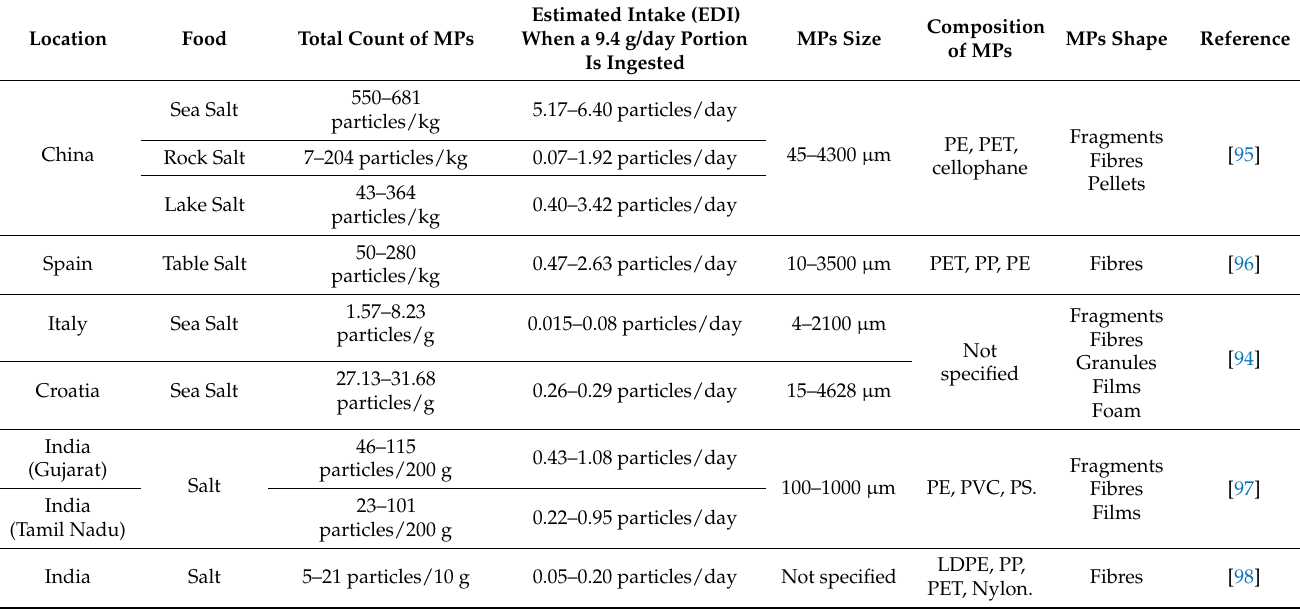
Table 4. MPs contents in salts and estimated daily intake in a 9.4 g salt/day consumption